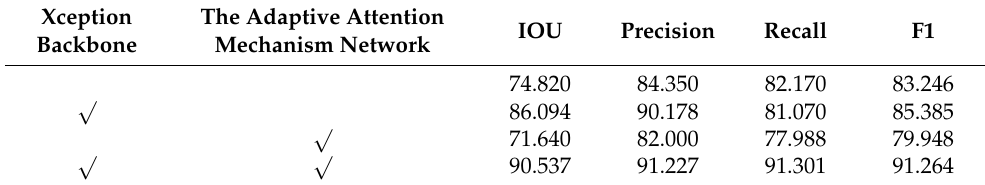
Table 3. Contribution comparison of different components.